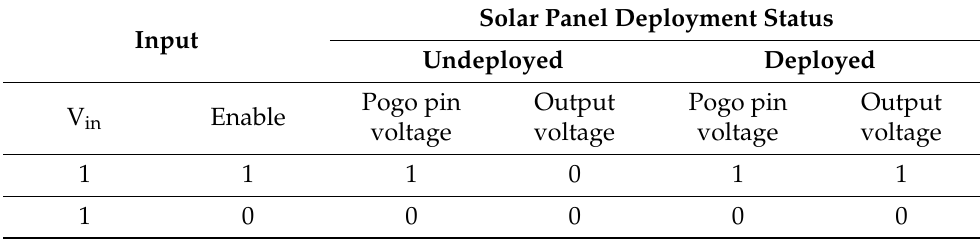
Table 6. Circuit truth table for deployment status of solar panel.